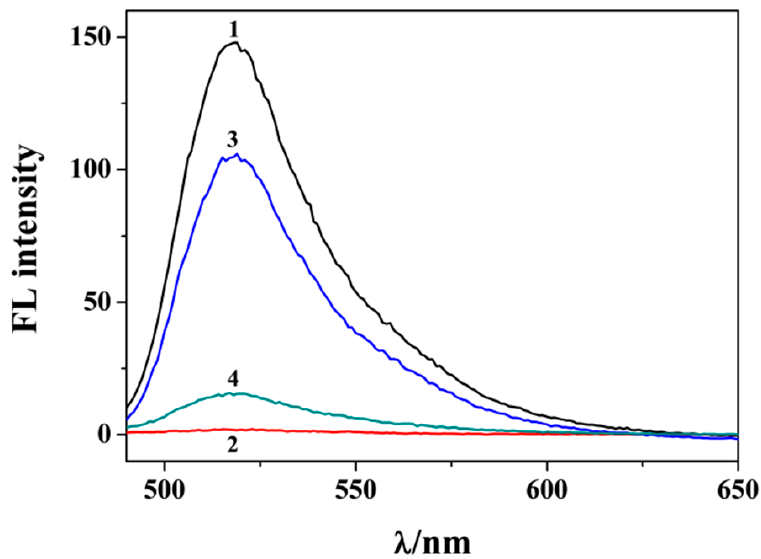
Figure 1. Fluorescence spectra of different systems: FITC-GDEVDGH 6 (curve 1), FITC-GDEVDGH 6 + Ni-NTA-MNP (curve 2) and FITC-GDEVDGH 6 /Cas3 + Ni-NTA-MNP (curve 3). Curve 4 corresponds to that of incubation of FITC-GDEVDGH 6 /Ni-NTA-MNP with Cas3. The concentrations of FITC-GDEVDGH 6 and Cas3 used were 500 nM and 100 ng/mL.